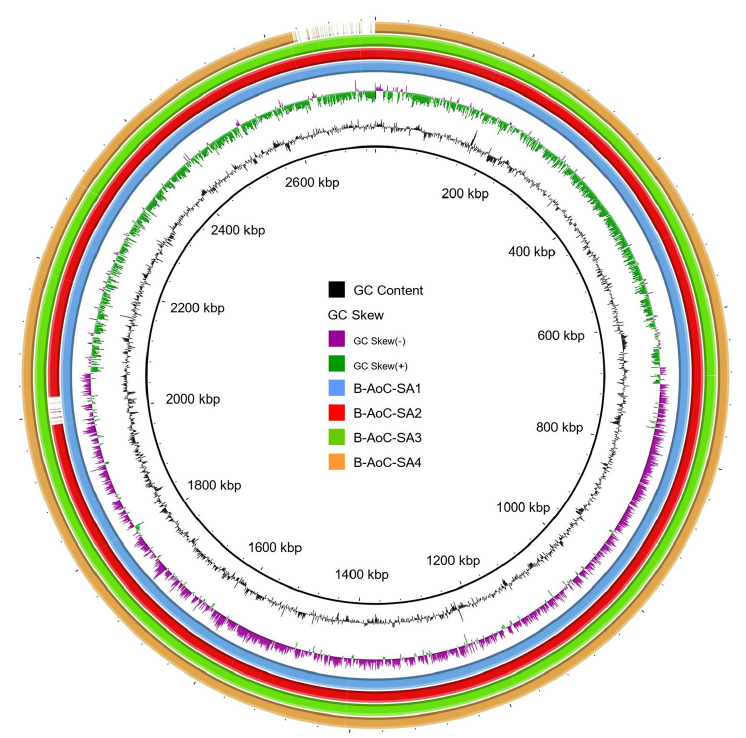
Figure 2. BRIG analysis of MRSA genomes isolated from bat guano. Genomes of B-AoC-SA2 (red ring), 3 (green ring), 4 (orange ring) isolates were compared against the genome of B-AoC-SA1 (blue ring) isolate using BRIG software [32]. Only regions with >90% nucleotide identity are colored. Lower identity percentage or no match are represented by blank spaces in each ring.